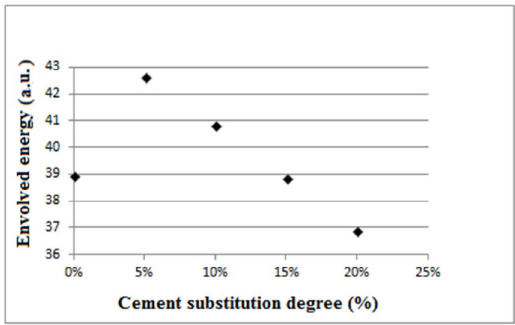
Figure 5. Envolved energy by samples with different percentage of NaCl in their hydration water for C